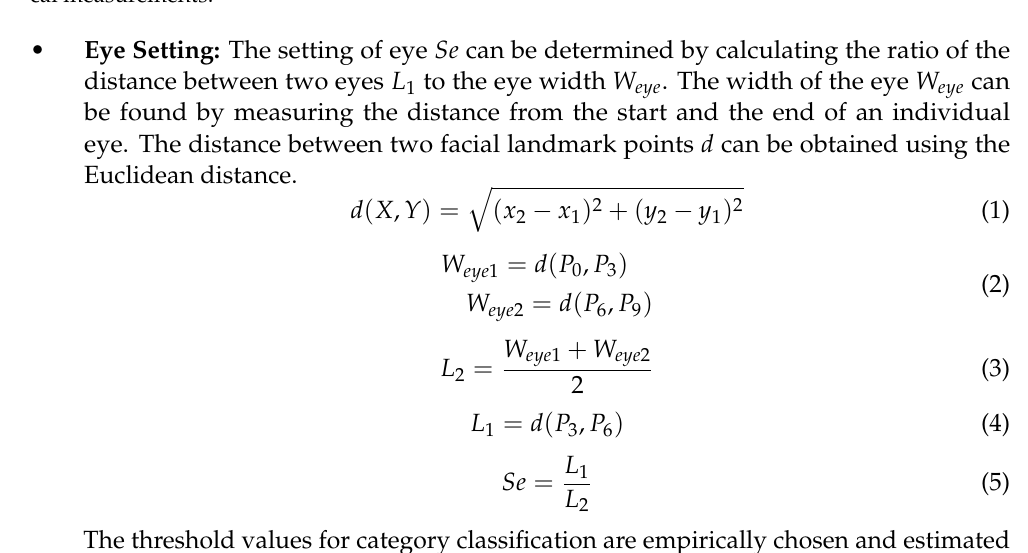
Figure 7. The six landmarks taken into consideration to predict the eye attributes using geometri- cal measurements.